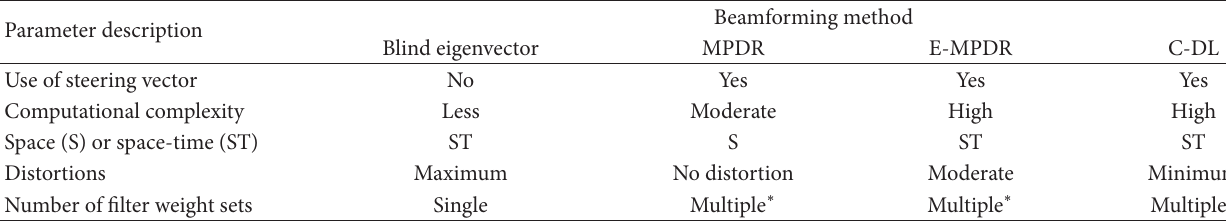
Table 1: Comparison of few features offered by beamformers.